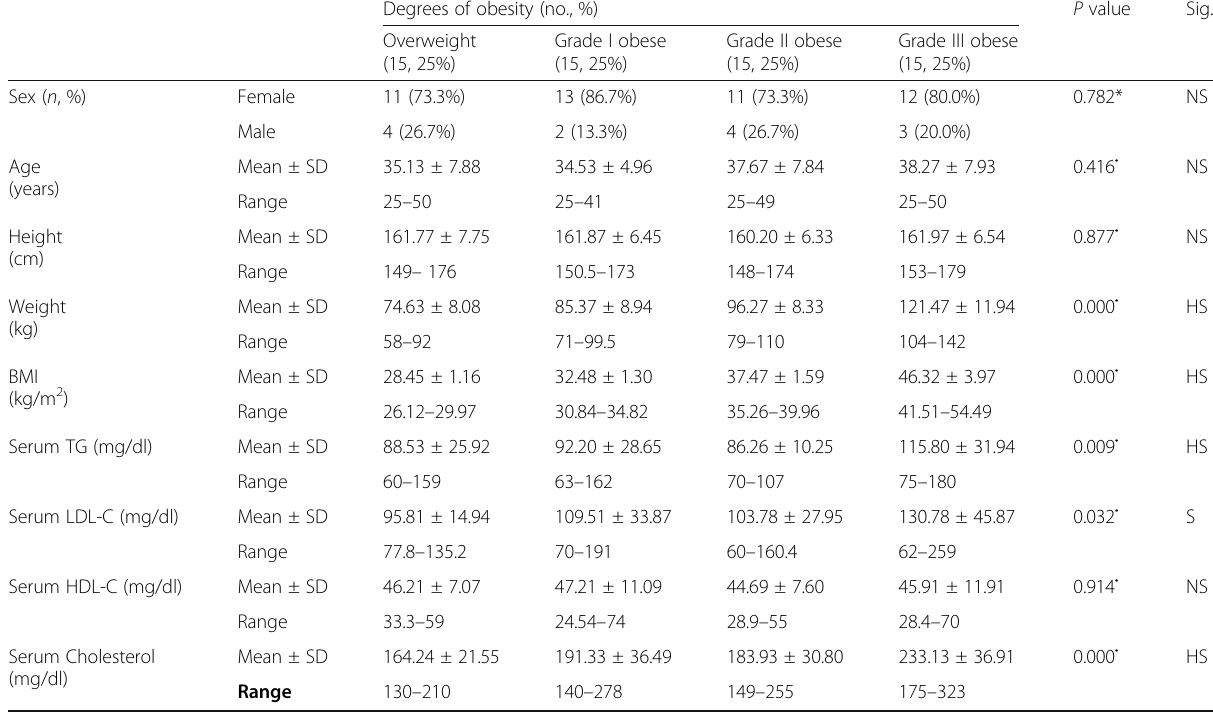
Table 2 Comparison of general characteristics, anthropometric measures, and serum lipids between subjects with overweight and obesity in different grades Degrees of obesity (no., %) P value Sig.